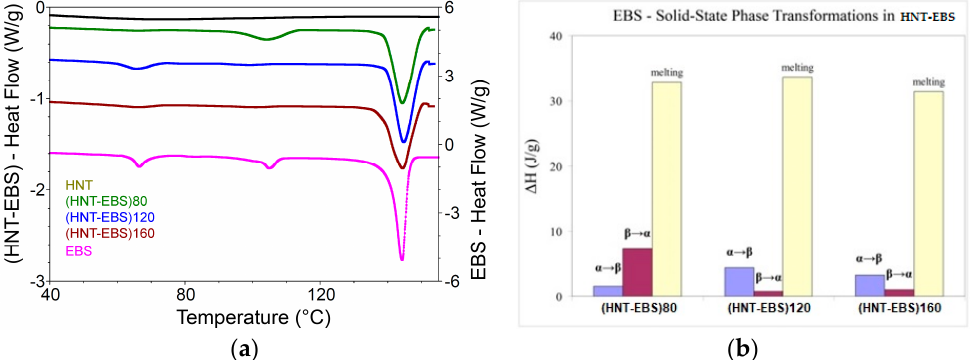
Figure 3. Phase transition of EBS in the HNT-EBS fillers obtained in different processing conditions compared with initial neat EBS and HNT. ( a ) DSC thermograms; ( b ) enthalpies of phase transformations (alpha-beta, beta-alpha and melting) of EBS in HNT-EBS fillers.